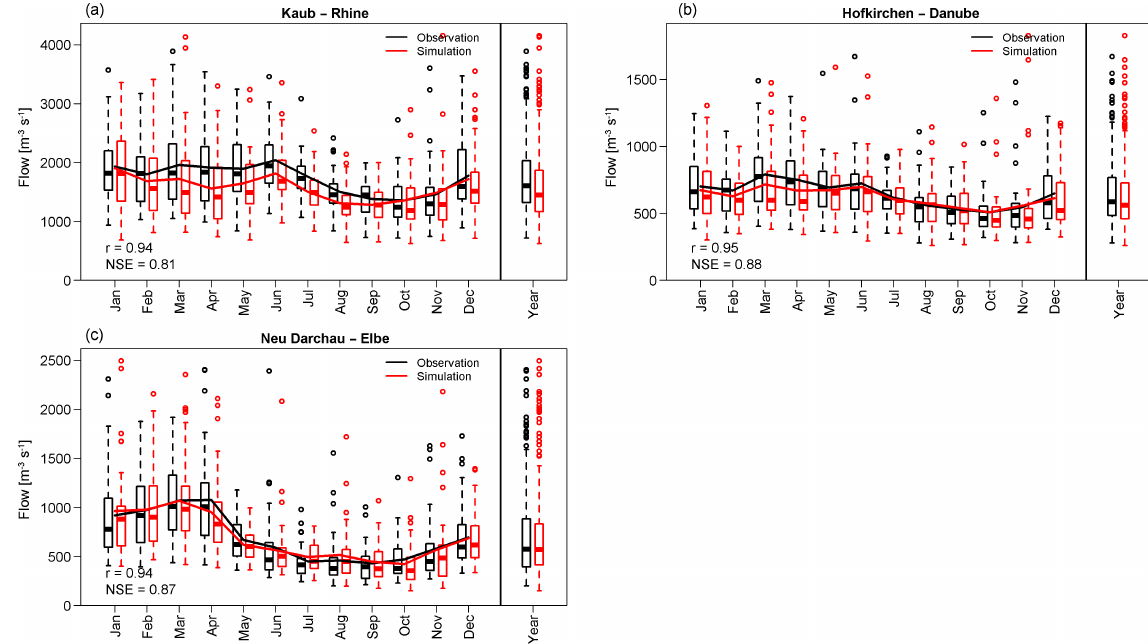
Figure 3. Comparison of the simulated (red) and observed (black) long-term (1981–2015) monthly mean streamflow and the distribution of the simulated and observed monthly mean streamflow within the different months and for the whole year illustrated as box-and-whisker plots of the gauges Kaub–Rhine (a) , Hofkirchen–Danube (b) and Neu Darchau–Elbe (c)